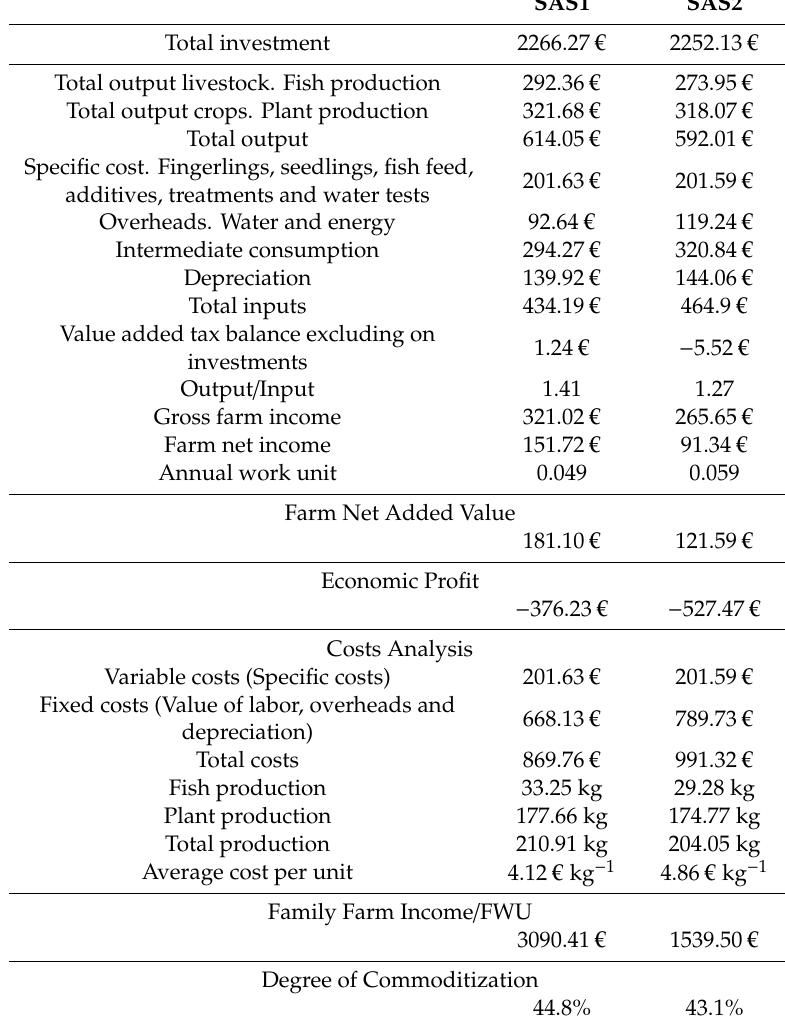
Table 2. Economic valuation of the two aquaponic systems. Total investment, farm net added value, economic profit, cost analysis, family farm income per family work unit and degree of